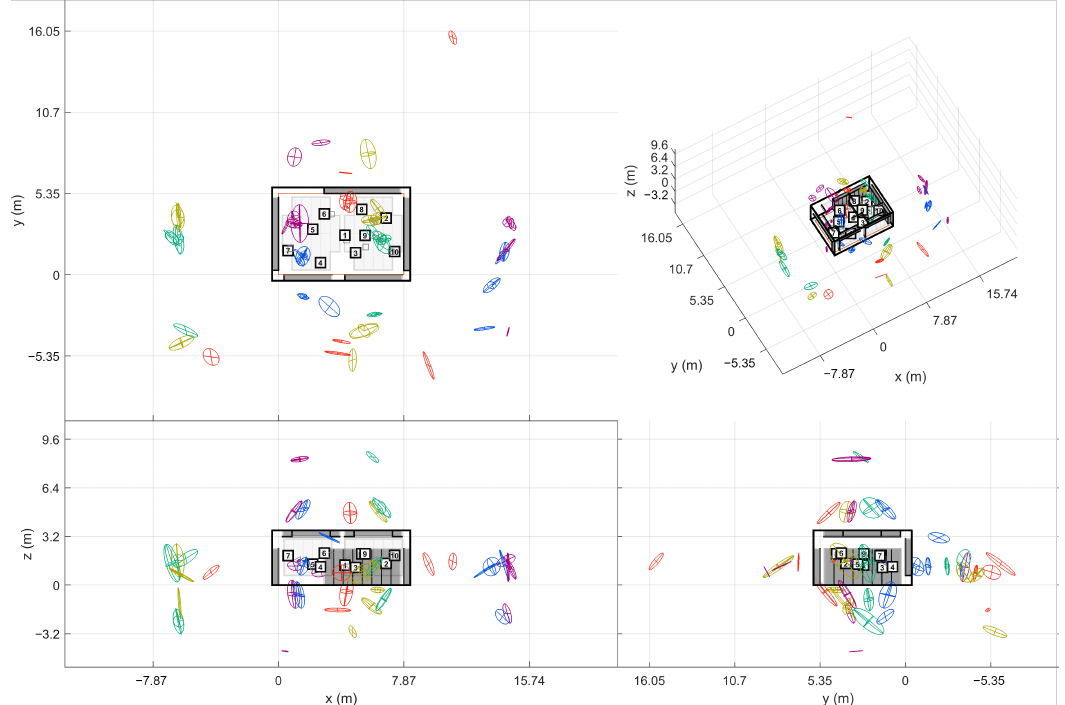
Figure A1. Found image sources for five loudspeaker positions in variable acoustics room Arni (min. 3 ER objects per image source). The 5 sound sources and the detected image sources have been plotted with different colors.